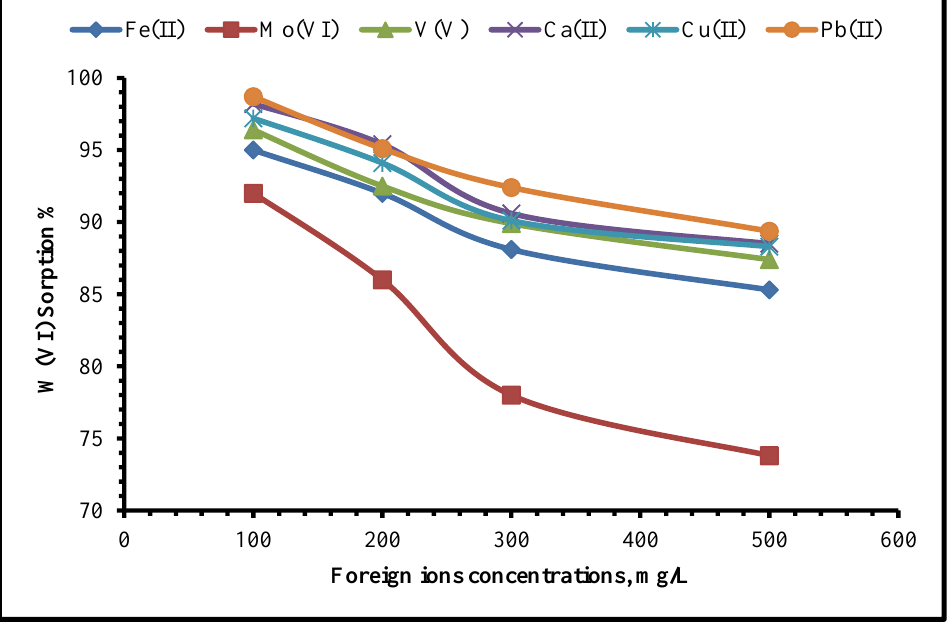
Figure 15. Effect of foreign ions on the adsorption % of W(VI) using HNAP/QA (pH 4.5, 20 mL solution, 30 min, 0.08 g, room temperature).